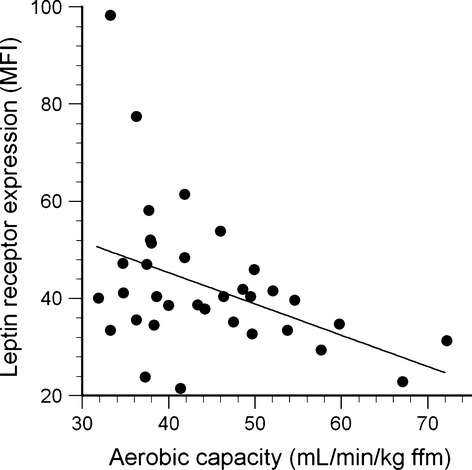
Leptin receptor expression on CD14++ monocytes plotted as a function of aerobic capacity (R = −0.42, P = 0.01).